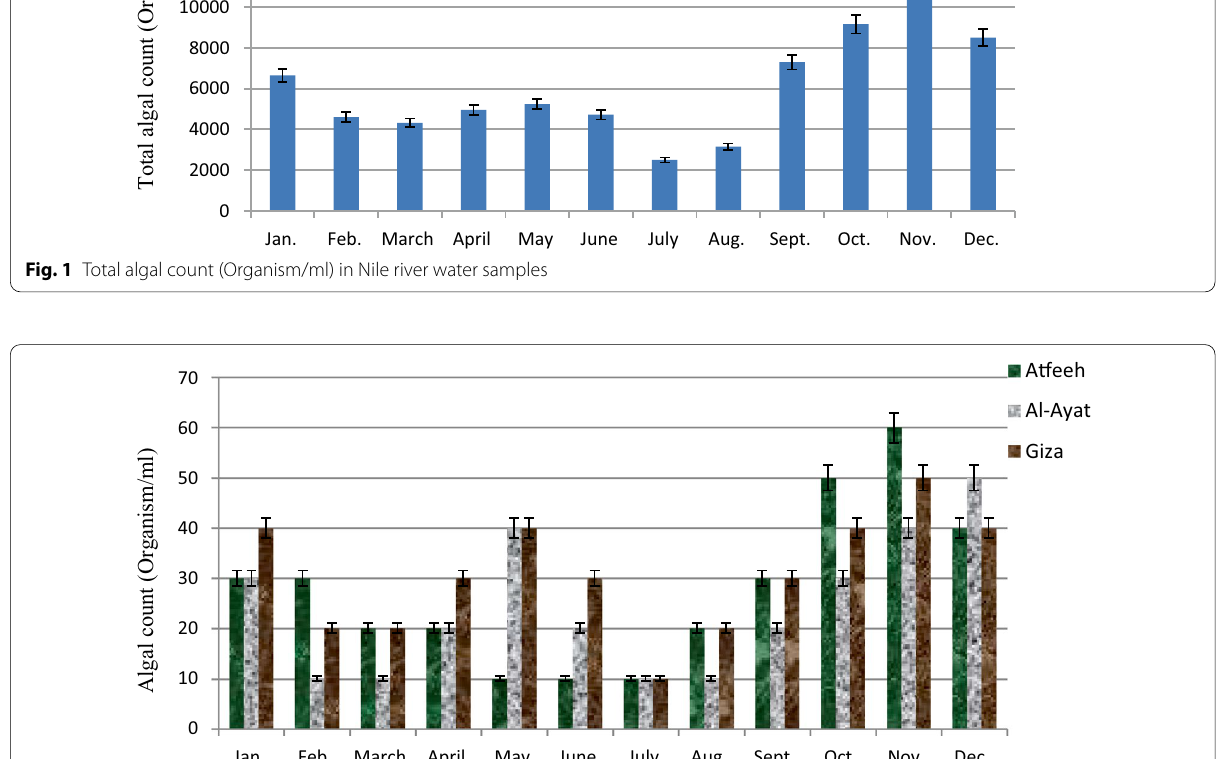
Fig. 2 Algal count (Organism/ml) in the treated water